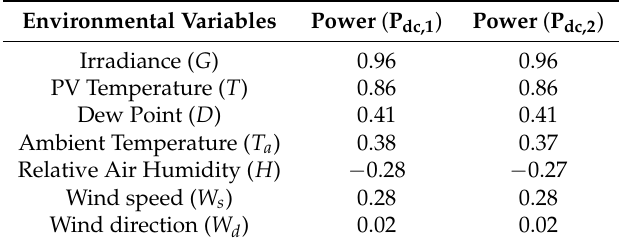
Table 3. Correlation index between environmental variables with the power of each